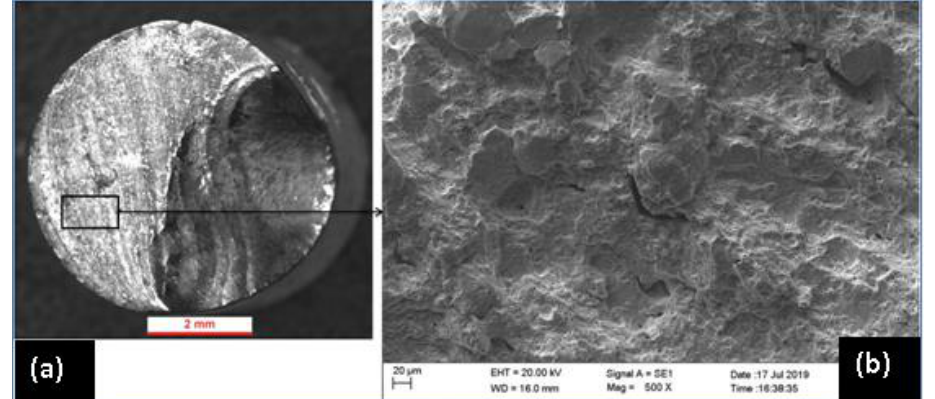
Fig. 8: SEM fractographs of failed bolt head in Branson cleaned